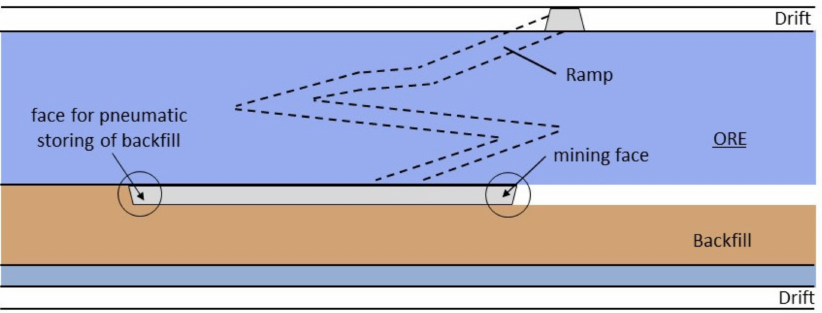
Figure 15. Longitudinal section: cut-and-fill mining with concrete backfill at the Bad Grund Mine for lead–zinc–silver in Germany (after Bartels, 1992 [64]).